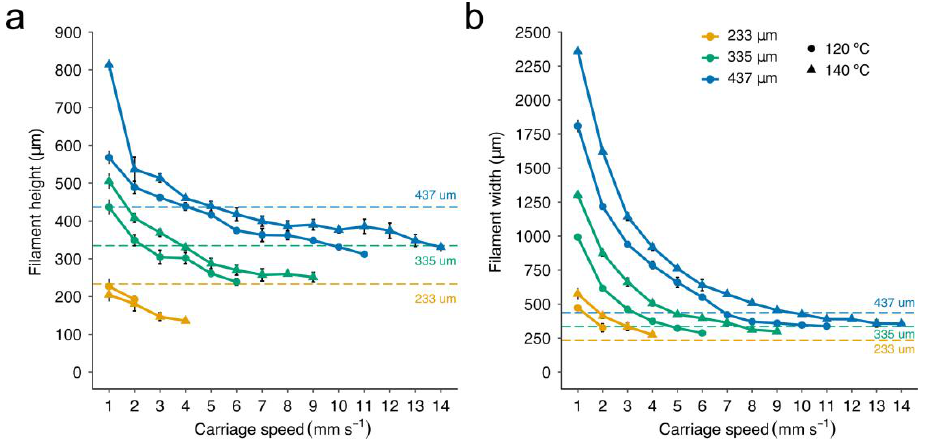
Figure 6. Evolution of the dimensions of the strands of PCL printed versus carriage speed. ( a ) The height and ( b ) the width of the strands for the three studied conical nozzles were measured at a pressure of 700 kPa and target temperatures 120 °C and 140 °C. Data represent the mean and standard deviation of six different samples (n =